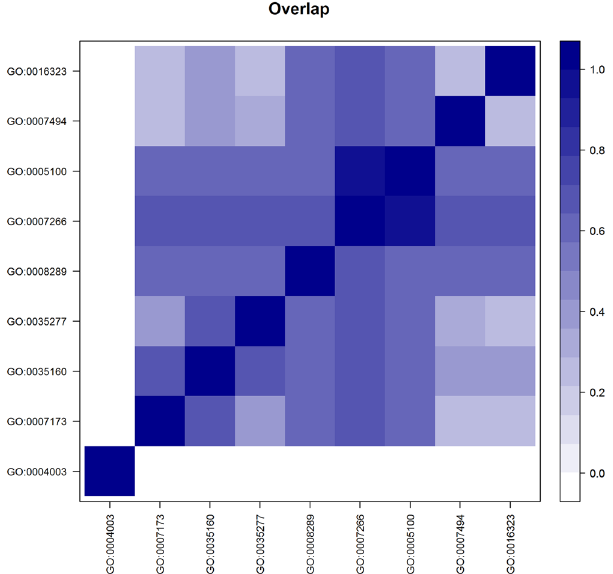
Figure 6. Heatmap showing the overlap between SNPs of significant GO terms. Each square [ i , j ] shows the proportion of SNPs associated with GO term i , as well as GO term j . Where i indexes rows and j indexes columns. Darker colours represent larger proportions of SNPs that overlap between GO terms. Only the most significant GO terms, presented in Table 1, are included.